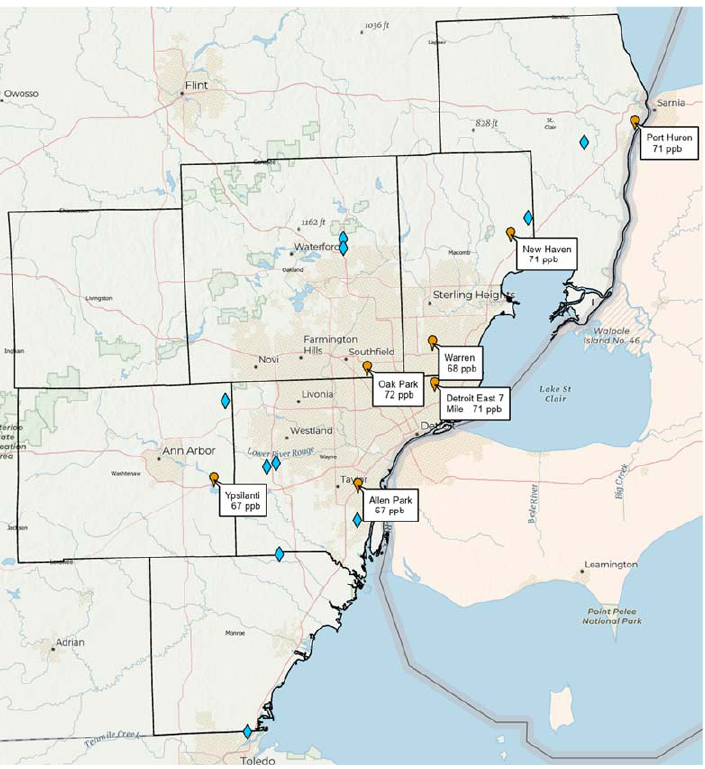
Figure 1. Locations of major solid waste landfills (blue diamonds) in the seven counties of the Southeast Michigan ozone non-attainment area relative to ozone monitoring stations (orange markers) run by the Michigan Department of Environment, Great Lakes, and Energy (EGLE). Stations are shown with corresponding 2018–2020 ozone design values.